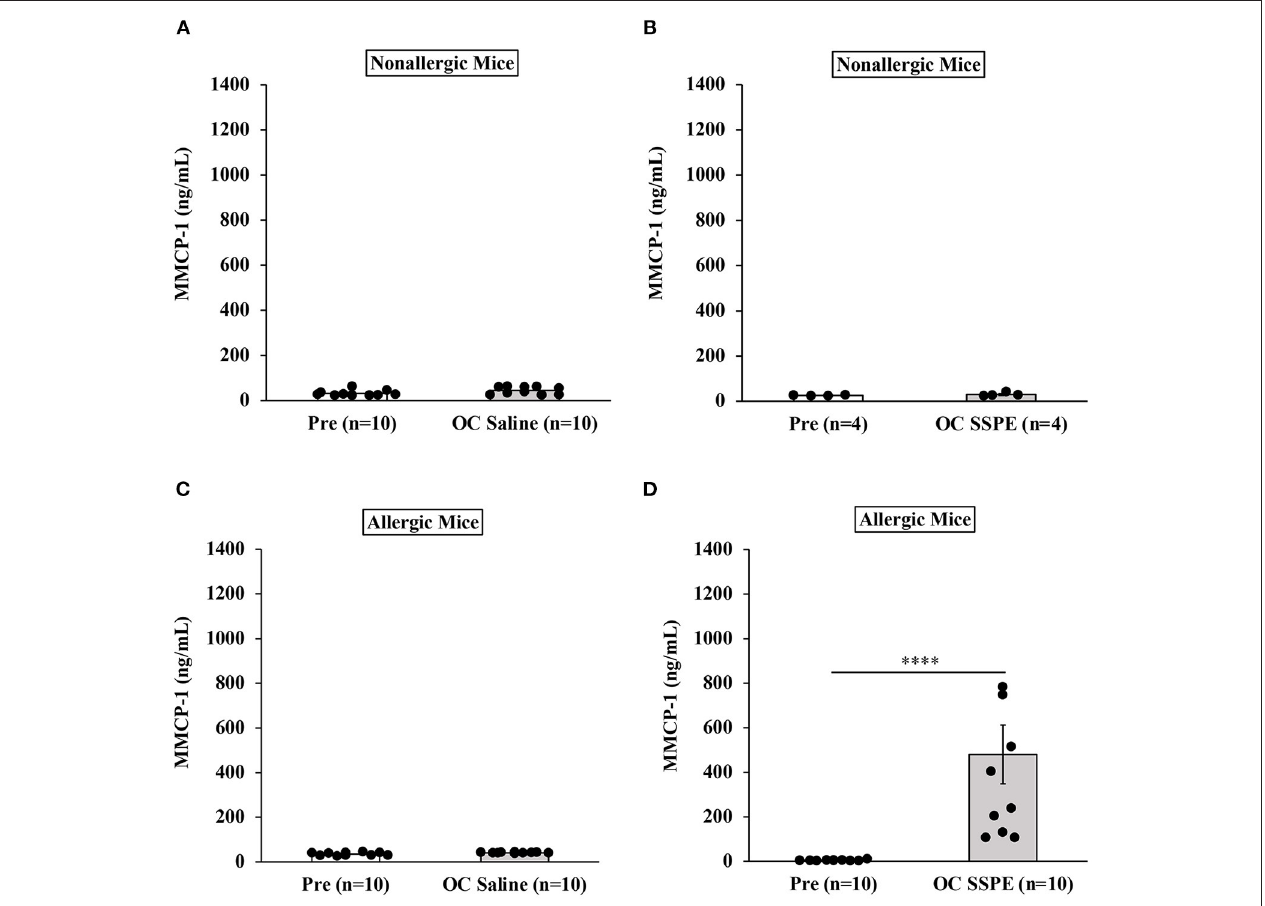
FIGURE 4 | Transdermally sensitized allergic mice exhibited degranulation of mucosal mast cells upon oral challenge with durum wheat (genomes AABB) SSPE. Mice were treated as described in MATERIALS AND METHODS. Their serum mucosal mast cell protease-1 levels (ng/mL) were measured using an ELISA-based method described in the texts. (A) MMCP-1 levels in control mice challenged with saline. (B) MMCP-1 levels in control mice challenged with durum SSPE. (C) MMCP-1 levels in allergic mice challenged with saline. (D) MMCP-1 levels in allergic mice challenged with durum SSPE. **** p < 0.001. MMCP-1, mucosal mast cell